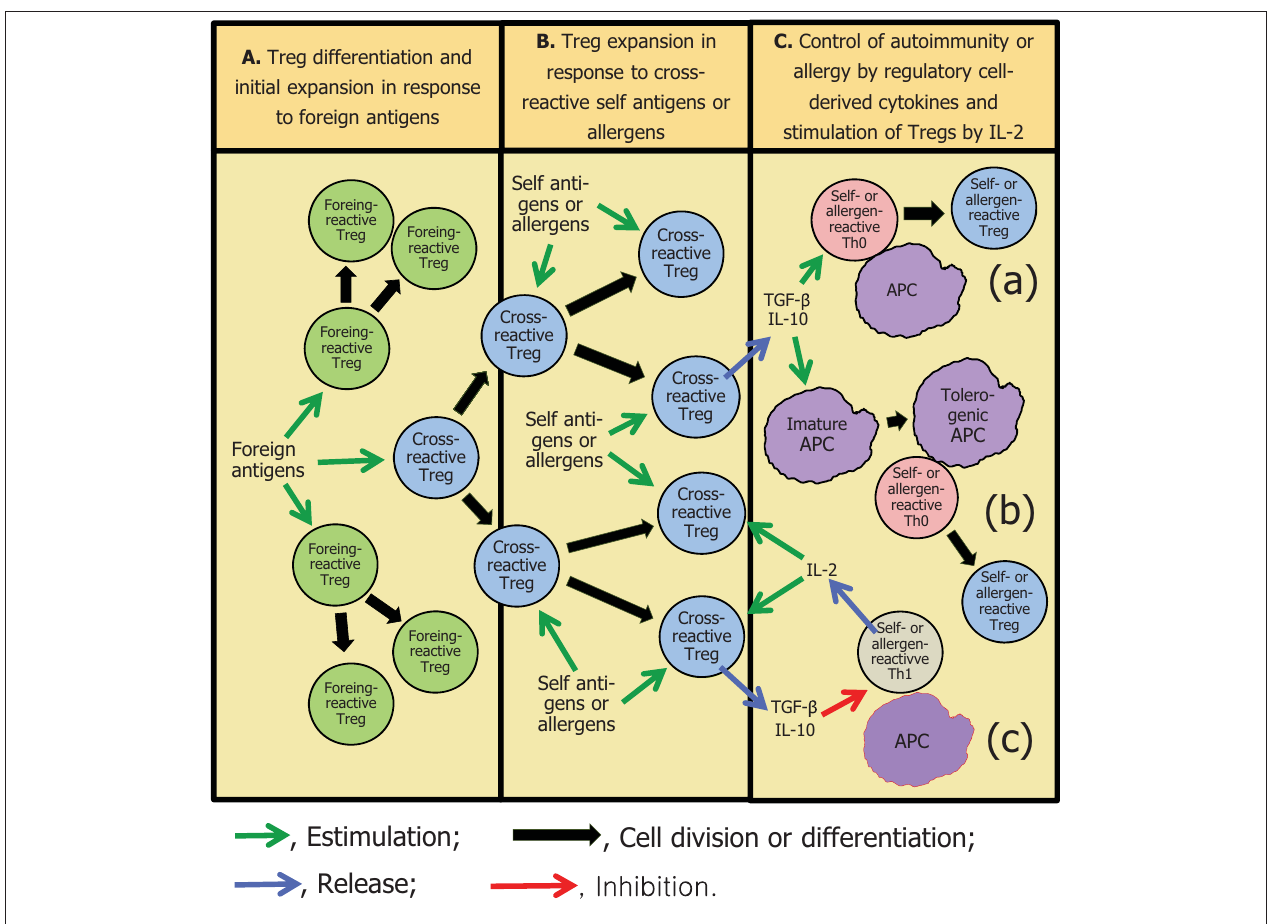
FIgure 1 | A possible mechanism for the maintenance of an infection- triggered immune regulatory environment. (A) Foreign, pathogen-derived antigens would activate and initially expand regulatory T cells (Treg) that crossreact with self-antigens and allergens, as well as pathogen-specific regulatory cells. (B) Self-antigens or common allergens would further expand and activate the crossreactive Treg cells. (C) Regulatory cell-derived IL-10 and TGF- β would inhibit potentially pathogenic immune responses by: (a) diverting the differentiation of naïve, Th0 lymphocytes to T regulatory lineages rather than to other,